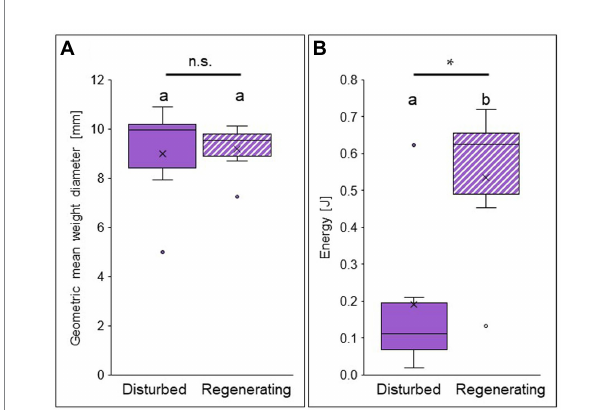
FIGURE 5 Aggregate stability against water erosion in biocrusts at opposite ends of the disturbance spectrum (disturbed site = filled in bars, and regenerating site = striped bars) in the Caatinga dry forest, NE Brazil. Geometric mean weight diameter of biocrust fragments after wet sieving in mm (A) and kinetic energy [Joule] input by raindrops necessary to break apart a biocrust aggregate (B) . Boxes represent the interquartile distance between the first and third quartile, the horizontal line the median, the cross the statistical mean, and the antennas the next closest point from an outlier within the data. p < 0.05 = *; n.s. = not significant; n = 6 each. For statistical results see Supplementary Tables S3,